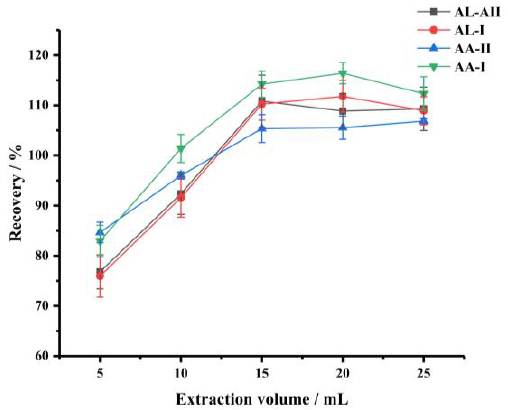
Figure 3. The effect of solvent volume (extraction solvent, methanol; extraction time, 30 min).